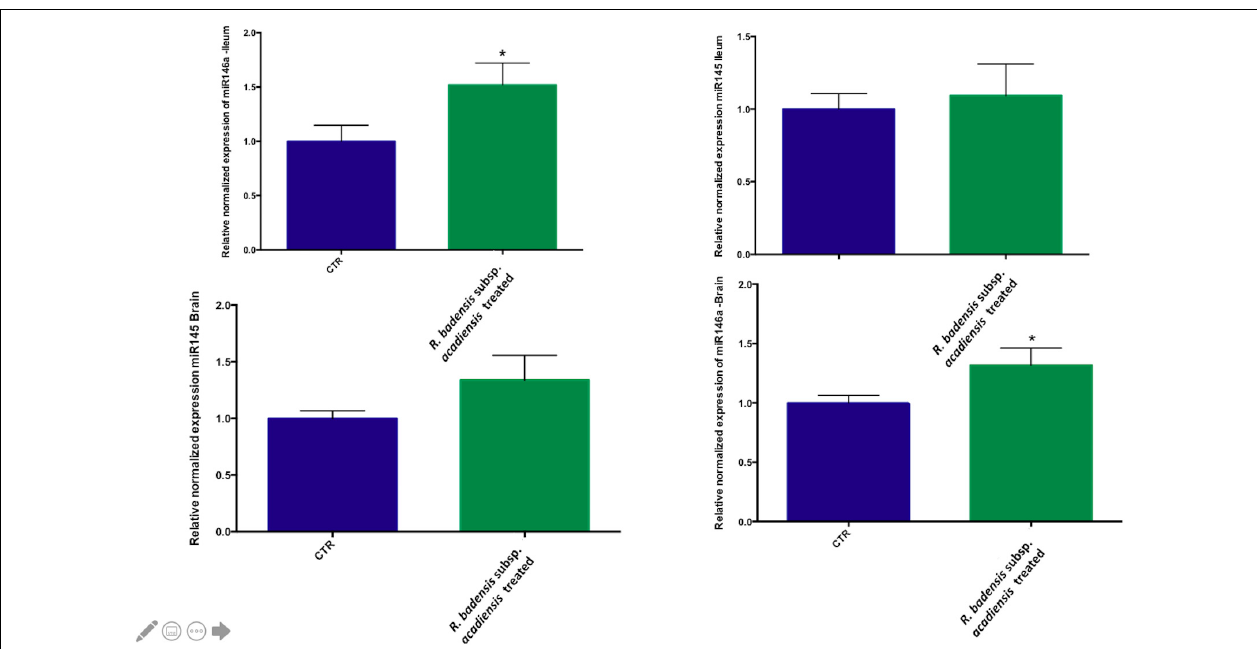
FIGURE 9 | Mean ± SEM of relative expression of miR145 and miR146a in the brain and ileum of (CTR) control mice fed 1% sucrose or R. badensis subsp. acadiensis treated group 10 8 CFU/mouse/day of Serratia vaccinia for 7 days. Significant difference between mice exists if * p < 0.05.